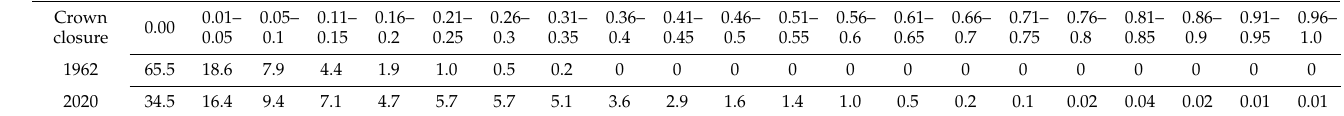
Table 1. Share (in %) of the total number of plots with different crown densities in 1962 and 2020 on the southern and eastern slopes of a hill with a height mark of 312 m a.s.l., near Mount Chernaya (Polar